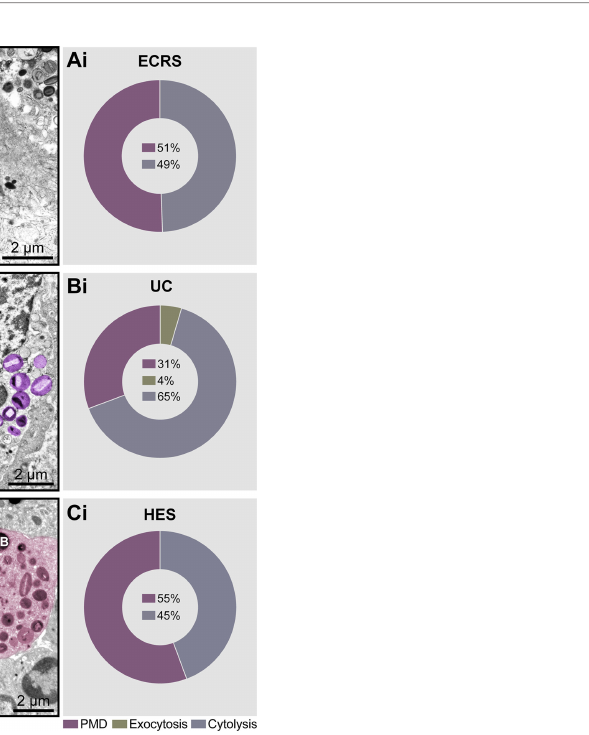
FIGURE 1 | Piecemeal degranulation (PMD) and cytolysis are the main modes of eosinophil secretion in human eosinophil-associated diseases (EADs). (A – C) Representative micrographs of tissue eosinophils in the lamina propria of nasal sinuses (eosinophilic chronic rhinosinusitis/ECRS), lamina propria and submucosa of intestines (ulcerative colitis/UC), and papillary dermis (hypereosinophilic syndrome/HES), respectively. Eosinophils undergoing (PMD) (colored in pink) and cytolysis with deposition of free extracellular granules (FEGs, purple) are observed in the same fi eld. Biopsy samples were prepared for TEM as before (Melo et al., 2005). (Ai – Ci) Quantitative analyses demonstrate predominance of PMD and cytolysis in representative EADs. A total of 335 eosinophils (99 for ECRS, 156 for UC and 80 for HES) were randomly evaluated in a total of 66,000 m m² of tissue area from two patients with ECRS (n = 2), UC (n = 16), and HES (n = 2). Gr, secretory granules; N,